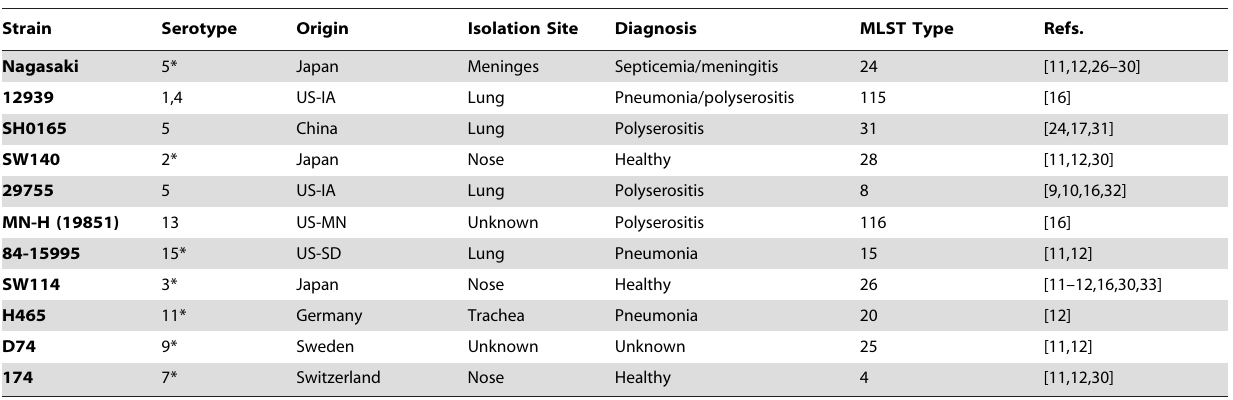
Table 1. H. parasuis